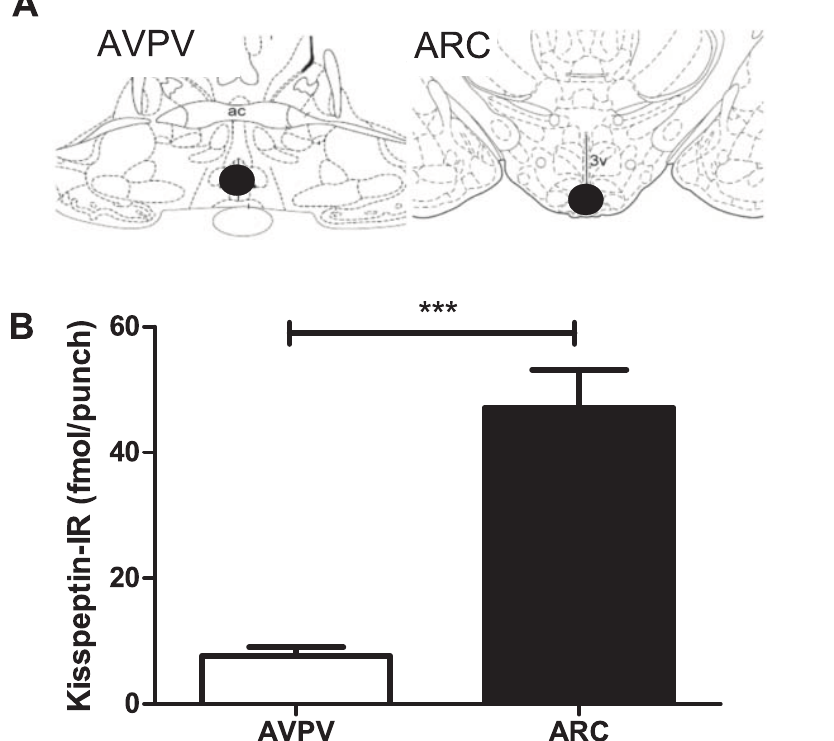
Figure 3. Quantification of kisspeptin-IR in the rat brain (A) Diagram of a rat brain coronal section showing the position of the punch microdissections for the Hypothalamic anteroventral periventricular nucleus (AVPV) and the arcuate nucleus (ARC). AVPV at bregma 2 0.26 mm and the ARC at bregma 2 3.30 mm according to the rat brain atlas of Paxinos and Watson. Black circles denote punch positions. Ac, anterior commissure; 3v, third cerebral ventricle. (B) Quantification of kisspeptin-IR in the AVPV and ARC of female rats by RIA. Significantly more kisspeptin-IR was detected in the ARC than in the AVPV. (Mean S.E.M, n=15 – 16, ***P , 0.001, Student’s t-test).